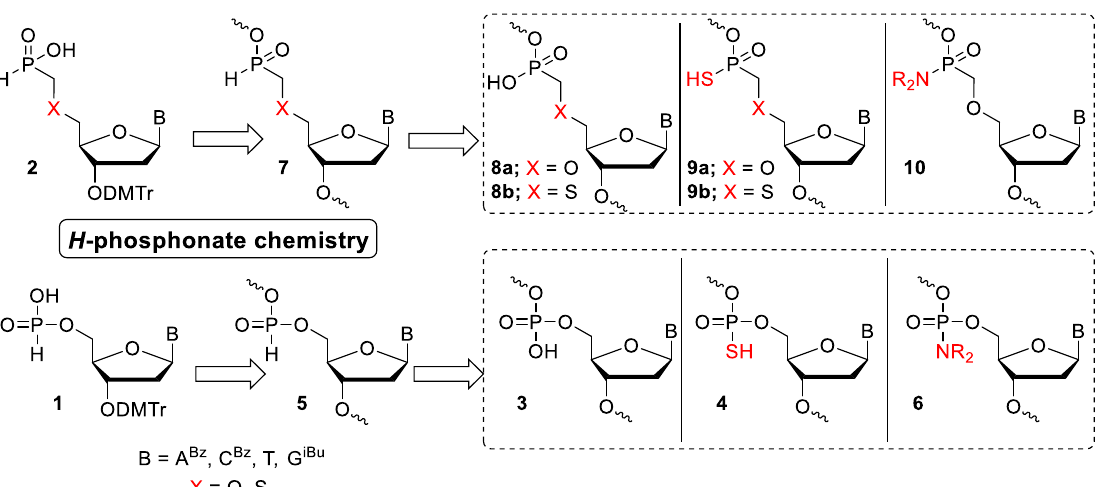
Figure 1. Overview of possible combinations of the phosphodiester 3 , 4 , 6 and phosphonate 8a , 8b , 9a , 9b and 10 linkages.